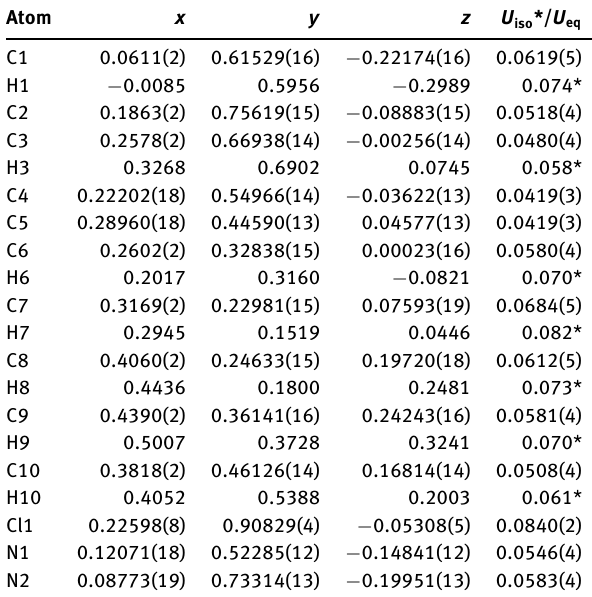
Table 2: Fractional atomic coordinates and isotropic or equivalent isotropic displacement parameters (Å 2